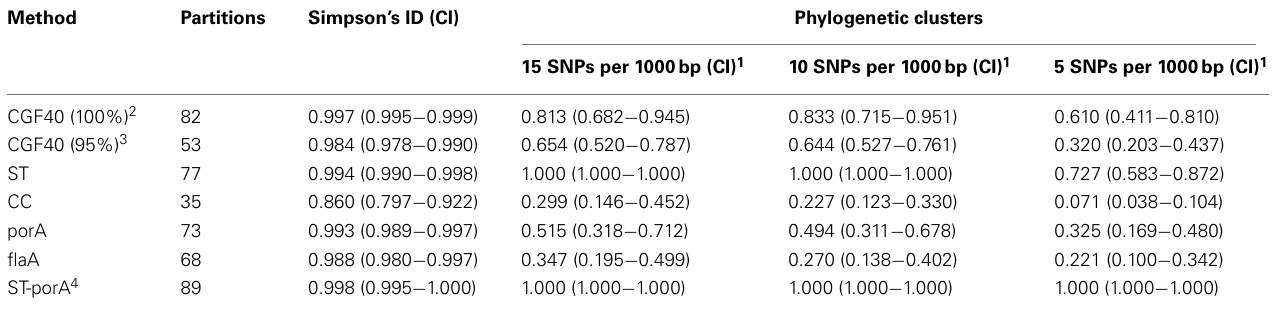
Table 1 | Comparison of metrics of subtyping method